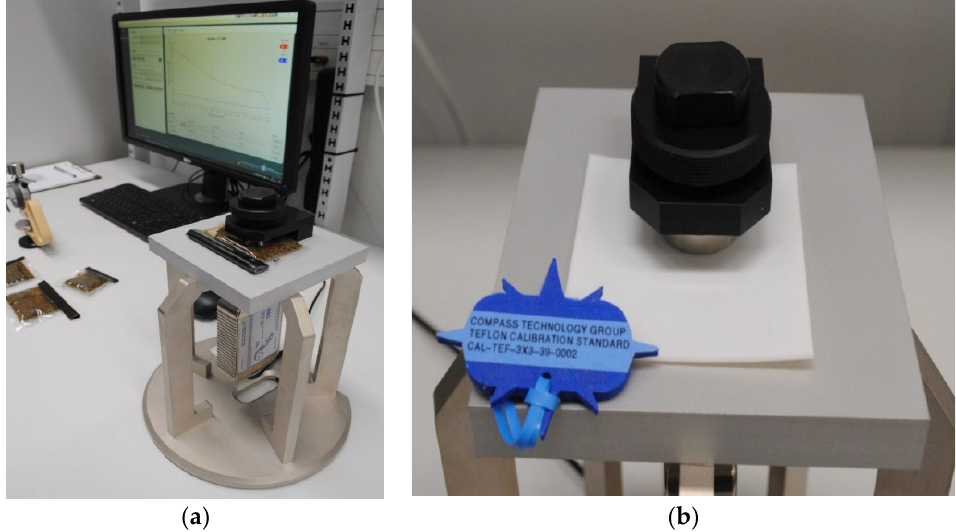
Figure 3. Permittivity measurement stand: ( a ) the set of equipment for the determination of dielectric parameters of bee homogenate samples, ( b ) the calibration set for the measurement stand.